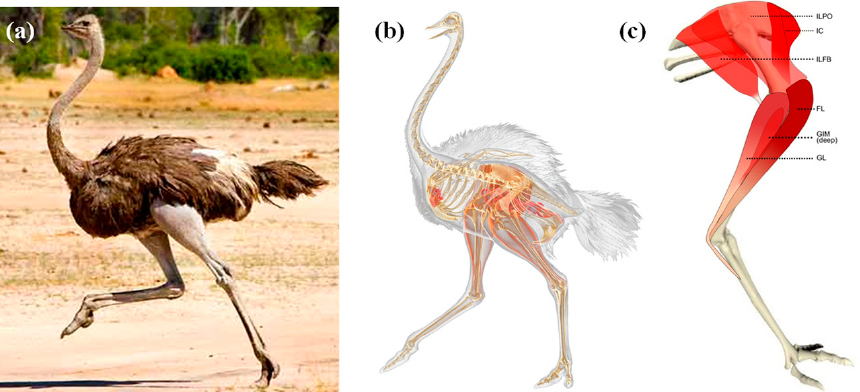
Figure 1. Ostrich and its leg structure: ( a ) ostrich running, ( b ) bone and muscle structure, ( c ) leg structure.